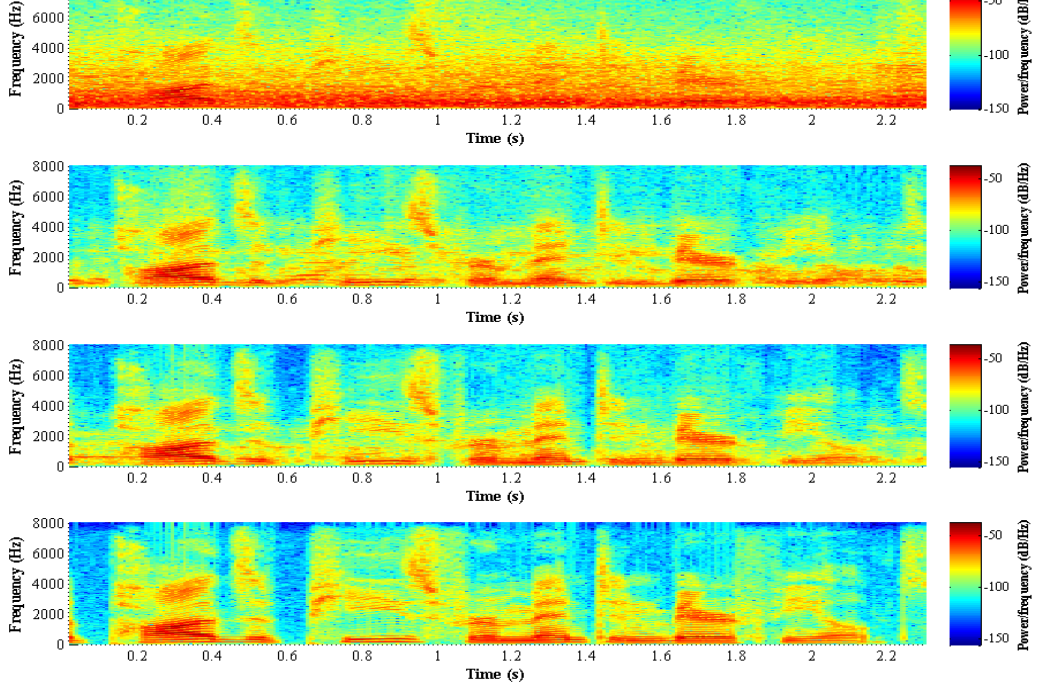
Figure 4. (From top to bottom) The spectrograms of noisy speech degraded by metro noise with − 3 dB signal-to-noise ratio (SNR), enhanced speech by the snT model, enhanced speech by the snDT model, and the corresponding clean speech,